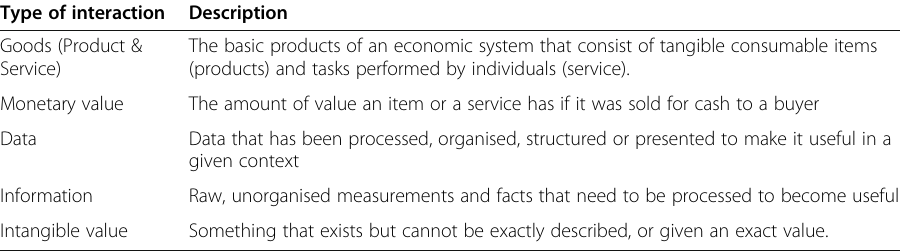
Table 3 Types of interactions in the business ecosystem (Ma et al.